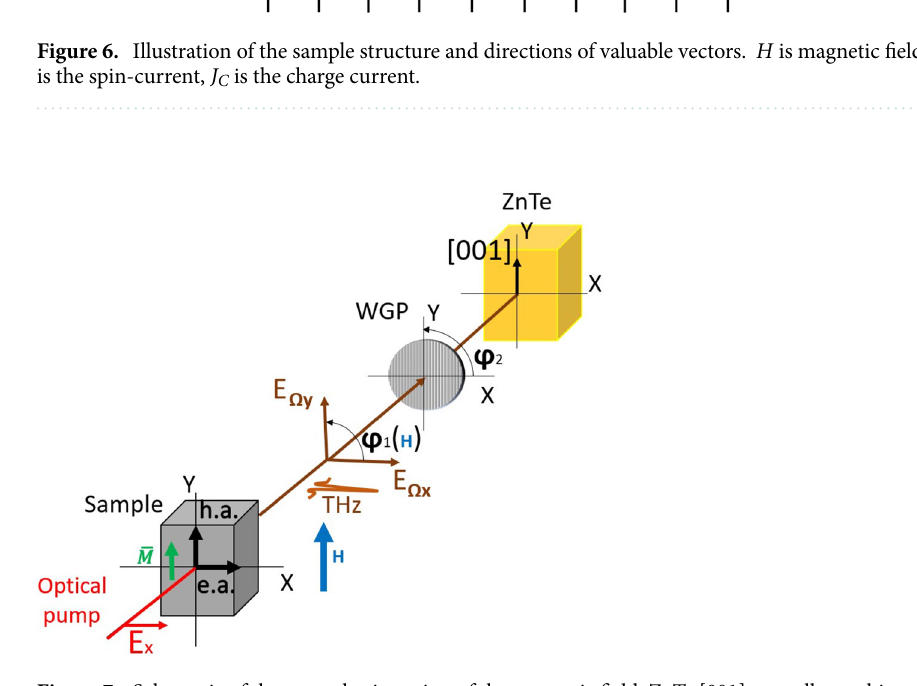
Figure 7. Schematic of the mutual orientation of the magnetic field, ZnTe [001] crystallographic axis, and polarization planes of optical and THz waves in “hard axis” geometry. XYZ—laboratory frame, ϕ 1 is the angle of rotation of THz wave polarization plane, ϕ 2 is the angle of rotation of the wire-grid polarizer